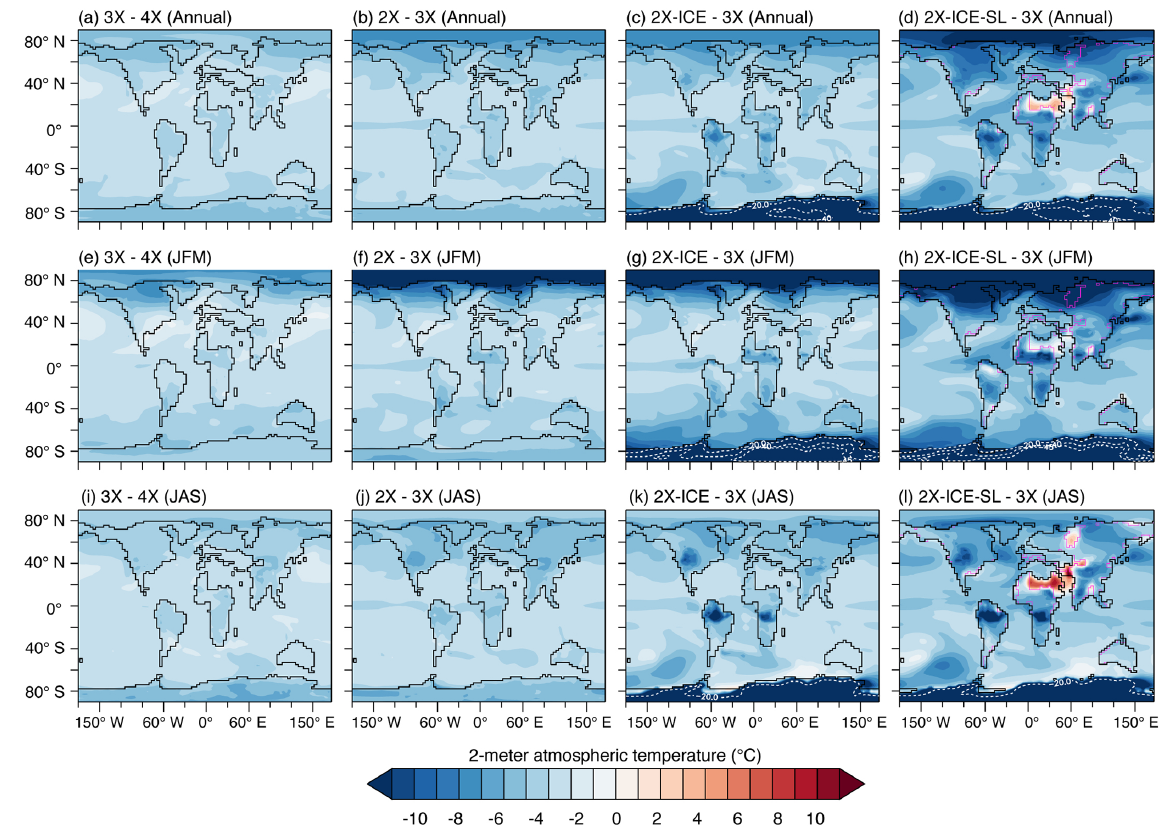
Figure 2. Two-meter air temperature changes ( ◦ C). JFM: averaged over January to March; JAS: averaged over July to September. Magenta lines of (d) , (h) and (l) indicate shorelines before sea-level lowering. White dotted lines in (c) , (d) , (g) , (h) , (k) and (l) are the level lines encircling the 20, 40 and 45 ◦ C cooling zones.